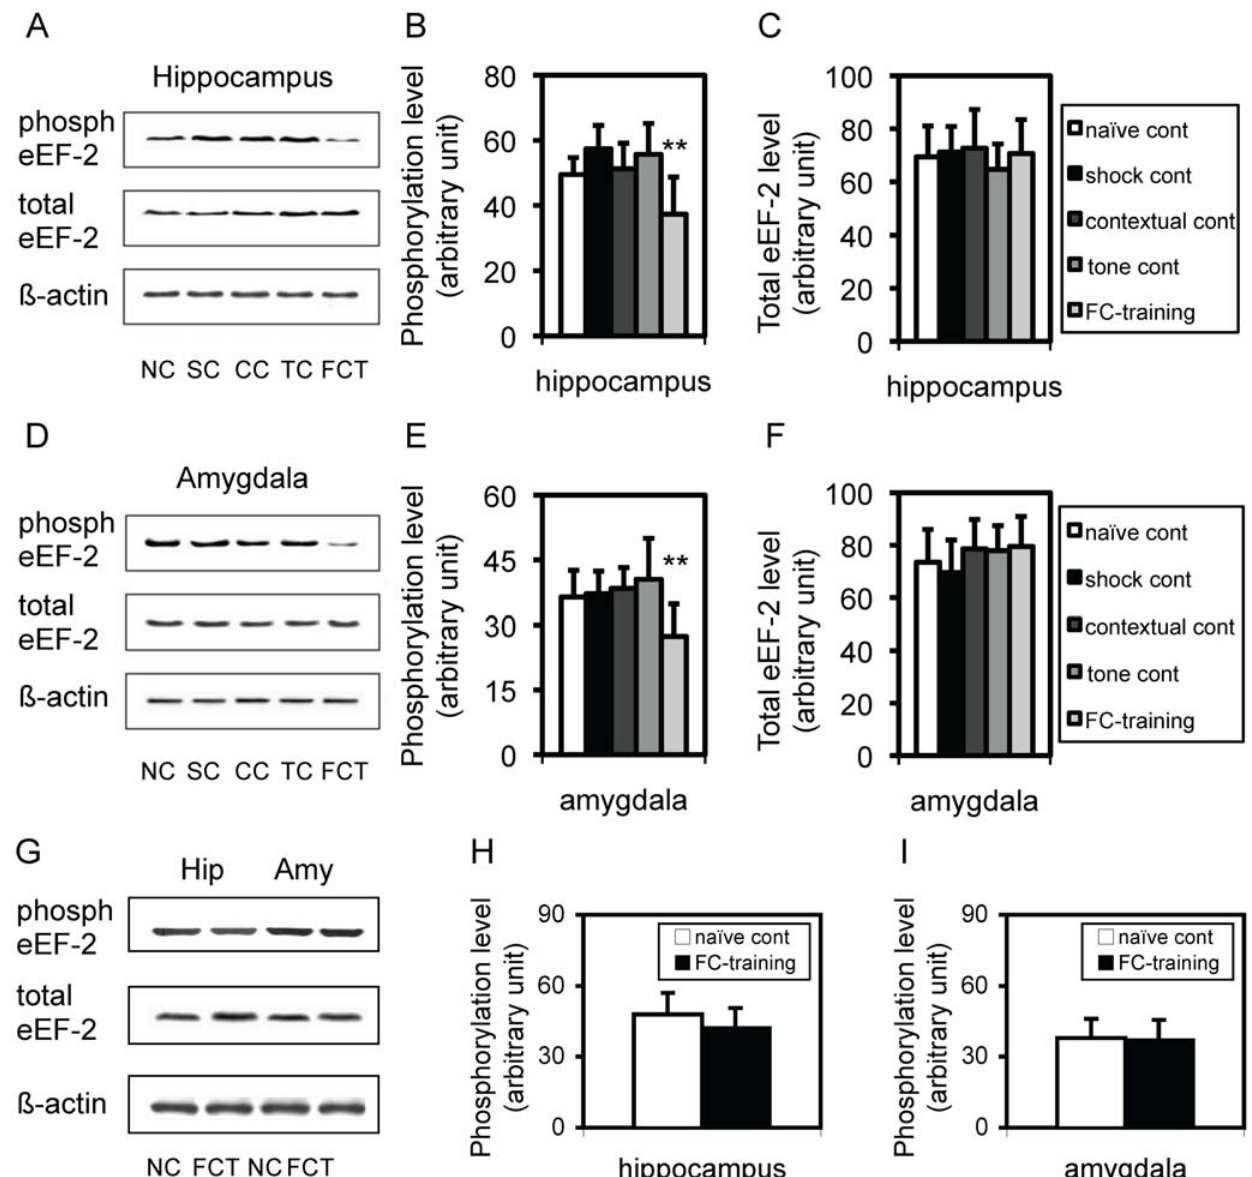
Figure 2. Dephospho-eEF-2 in both the hippocampus and amygdala is temporally associated with post-training. A . Representative Western blots showing the expression level of phospho-eEF-2 (phosph eEF-2; upper panel), total eEF-2 (middle panel), and b -actin (low panel) in hippocampi from mice that were sacrificed 30 min after the training. NC: naı¨ve control; SC: shock control; CC: contextual control; TC: tone control; FCT: fear-conditioning training. B . Quantitative analysis of phospho-eEF-2 in hippocampi from mice that were sacrificed 30 min after the training (n=5), in comparison to NC (n=6), SC (n=5), CC (n=5), and TC (n=5). C . Quantitative analysis of the total eEF-2 level in hippocampi of the same mice as described in B. D . Representative Western blots showing the expression level of phospho-eEF-2 (phosph eEF-2; upper panel), total eEF-2 (middle panel), and b -actin (low panel) in amygdalae from the same mice as described in B. E . Quantitative analysis of phospho-eEF-2 in amygdalae from the same mice as described in B. F . Quantitative analysis of the total eEF-2 level in amygdalae of the same mice as described in B. G . Representative Western blots showing the expression level of phospho-eEF-2 (phosph eEF-2; upper panel), total eEF-2 (middle panel), and b -actin (low panel) in both hippocampi (Hip) and amygdalae (Amy) from mice that were sacrificed 4 hr after the training. (H). Quantitative analysis of phospho-eEF-2 in hippocampi from NC (n=6) and trained mice (n=5) that were sacrificed 4 hr after the training in FCT. (H). Quantitative analysis of phospho-eEF-2 in amygdalae from the same mice as described in H. **, p , 0.01, one-way ANOVA.